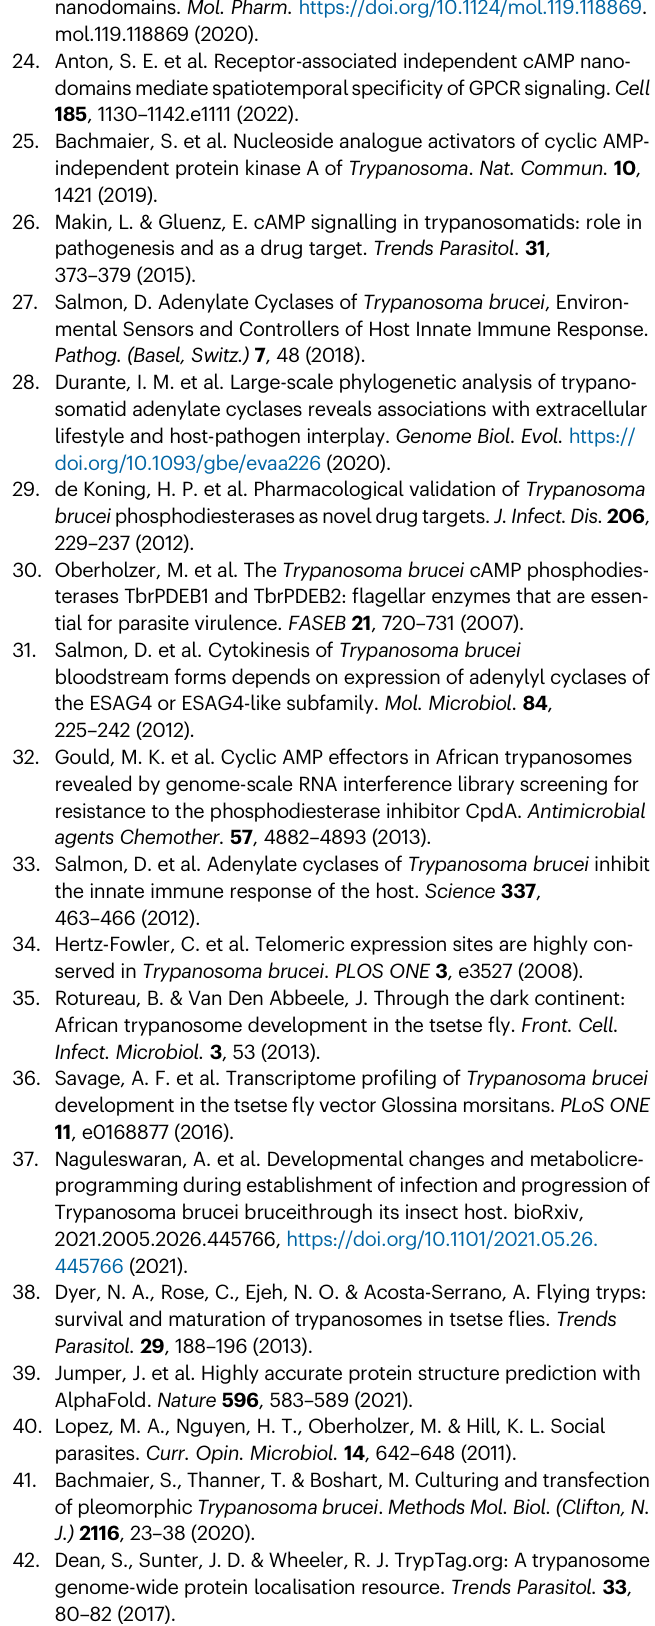
Supplementary Fig. 8g, h are provided as source data fi le. Source data are provided with this